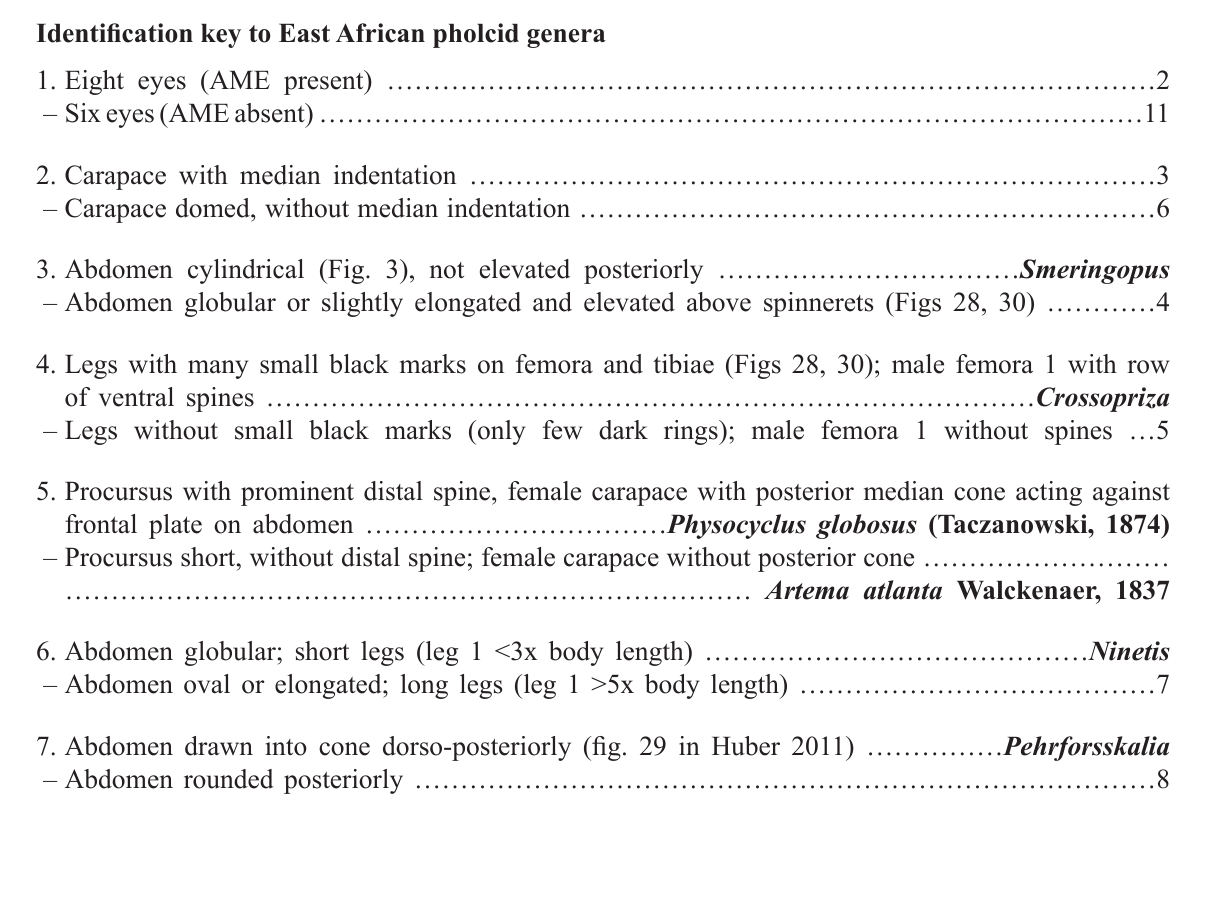
7. Abdomen drawn into cone dorso-posteriorly (fig. 29 in Huber 2011) ……………